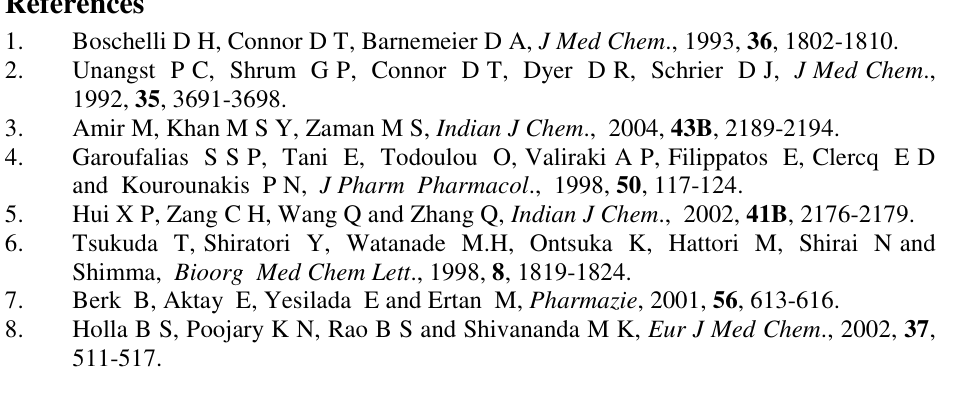
Table 2. Antimicrobial activities of the compounds. Compound